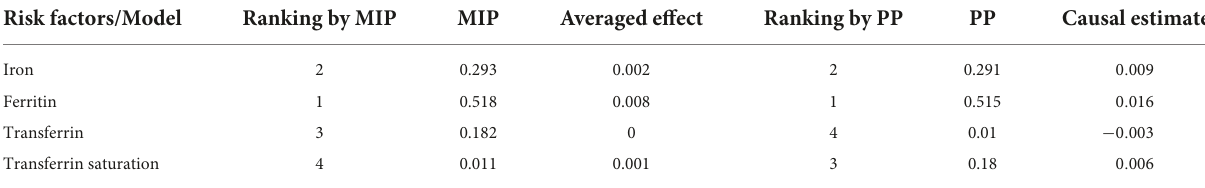
TABLE 5 Ranking of risk factors and models for back pain (MR-BMA analysis).